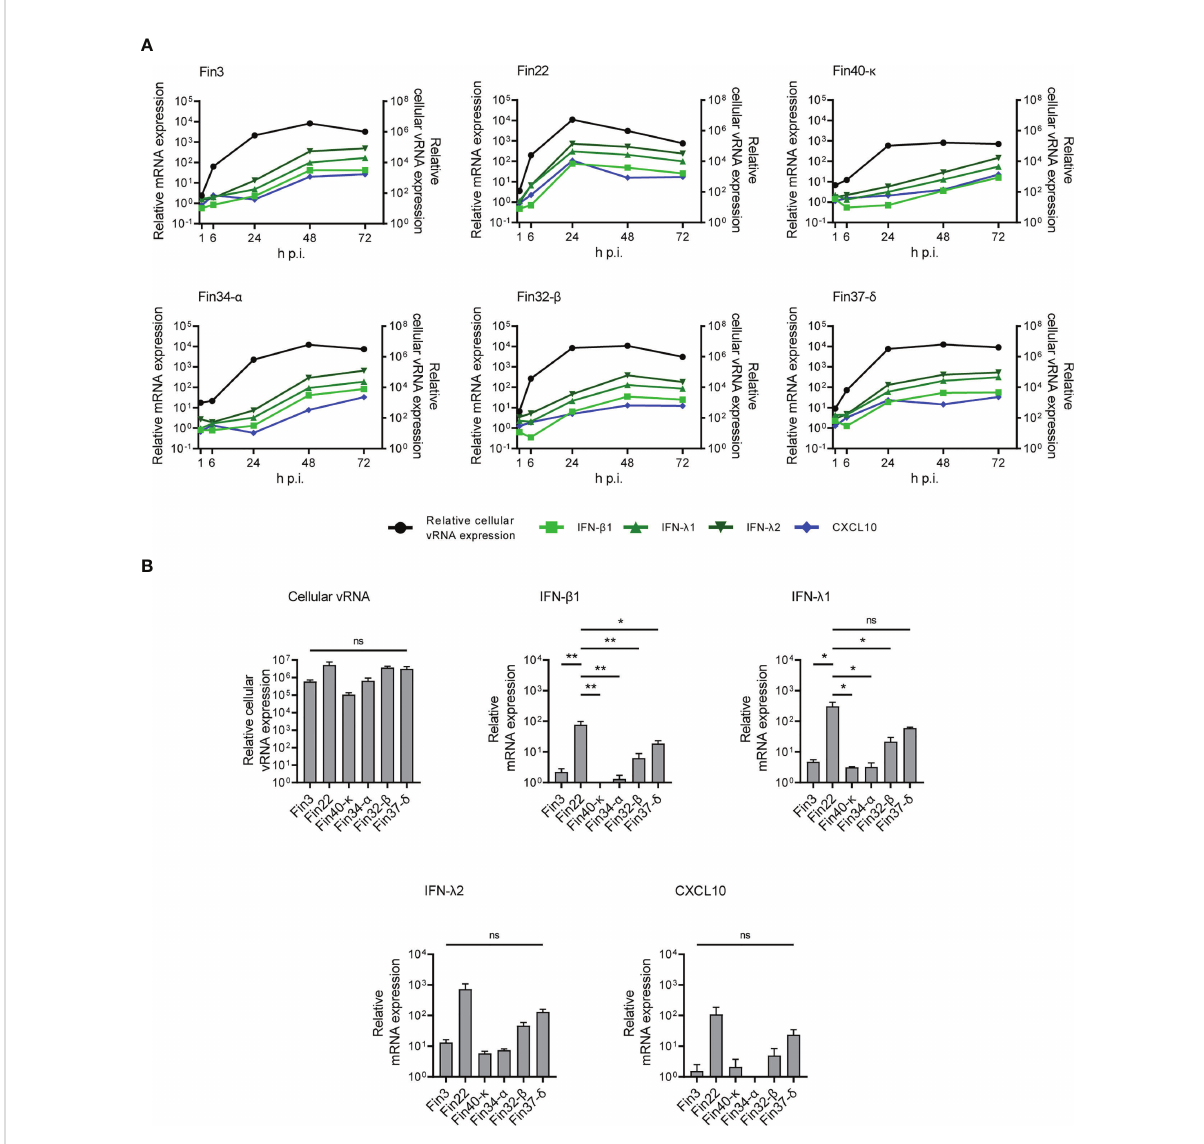
FIGURE 4 Interferon and CXCL10 mRNA expression levels in Calu-3 cells infected with SARS-CoV-2 variants. Cells were infected with each variant at a MOI of 1 TCID 50 /cell and total cellular RNA samples were collected at different time points during infection. (A) The kinetics of vRNA and host cell IFN- b 1, IFN- l 1, IFN- l 2 and CXCL10 mRNA expression pro fi les were determined by RT-qPCR. Relative cytokine mRNA expression pro fi les in different SARS-CoV-2 variant infected cells are shown on the left Y axes and the vRNA expression levels on the right Y axes. The means of three independent experiments are shown. (B) Comparative analysis of relative cellular vRNA and IFN- b 1, IFN- l 1, IFN- l 2 and CXCL10 mRNA expression at 24 h p.i. The results are the mean values ± SEM of three independent experiments. One-way ANOVA with Tukey ’ s multiple comparisons test was used for the statistics. P < 0.05 (*), P < 0.01 (**), not signi fi cant